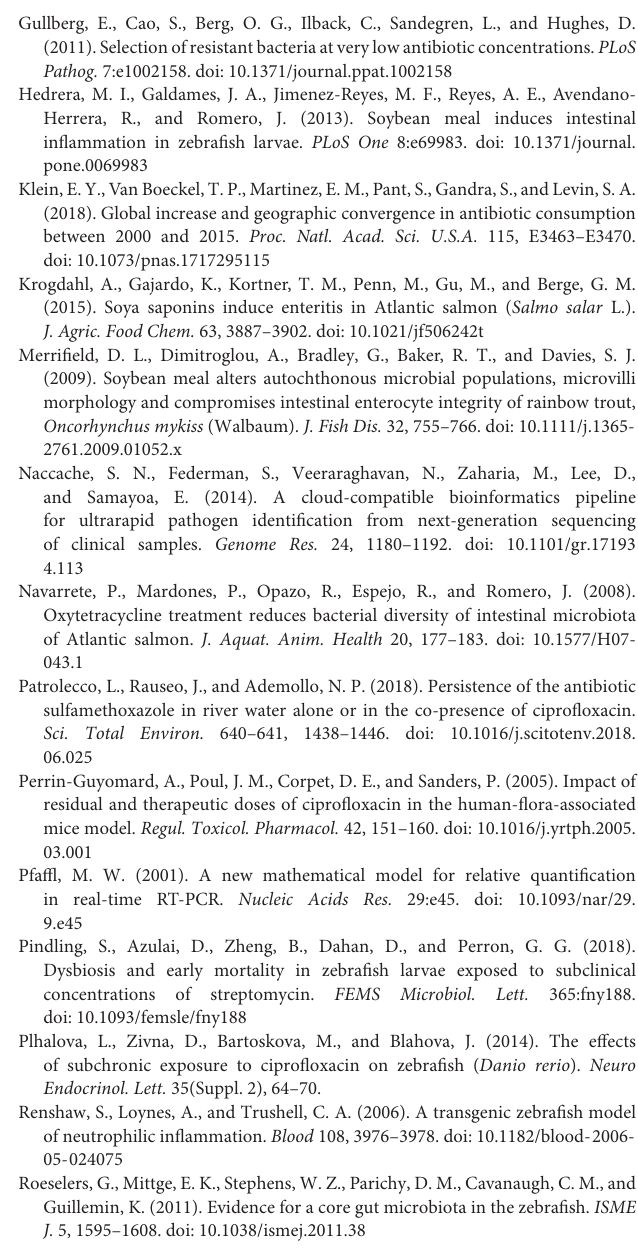
FIGURE S2 | Linear regression analysis of the neutrophil count in the intestinal area of the saponin dose-response experiment. FIGURE S3 | (A) Representative pictures of neutrophil and macrophage imaging at baseline (6 dpf) for control (E3), Ciprofloxacin and Oxytetracycline treated larvae (exposure from 4–6 dpf), (B) Quantification of neutrophil and macrophage number in the intestinal area ( n = 10 larvae/treatment). (C) Relative gene expression on pools of whole zebrafish larvae ( n = 4 pools of 5 larvae/ treatment) for the following cytokines: il-1 β , ccl2, cxcl8, (one way ANOVA Kruskal-Wallis test with Dunn’s Multiple comparison Post-Test, mean ± SEM. FIGURE S4 | The top 7–10 most abundant genera (mean ± SEM, ∗ p < 0.05) are displayed: (A) Unclassified Betaproteobacteria (B) Aeromonas (C) Rhizobium (D) Unclassified